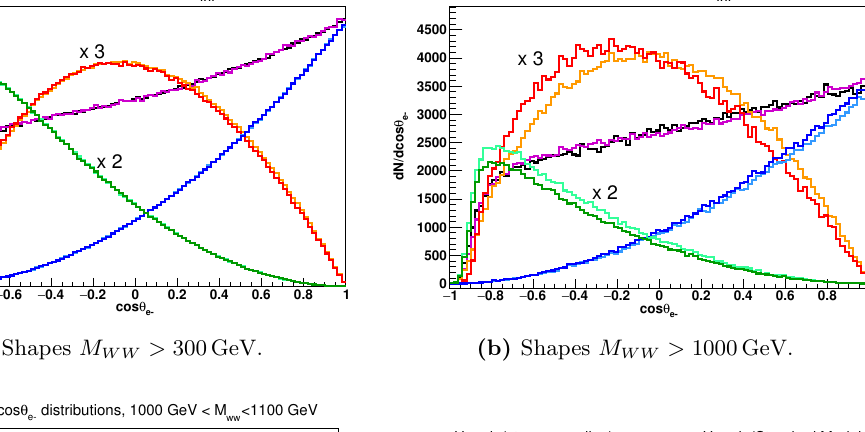
> 20 GeV, j (cid:17) e j < 2 : 5. The t